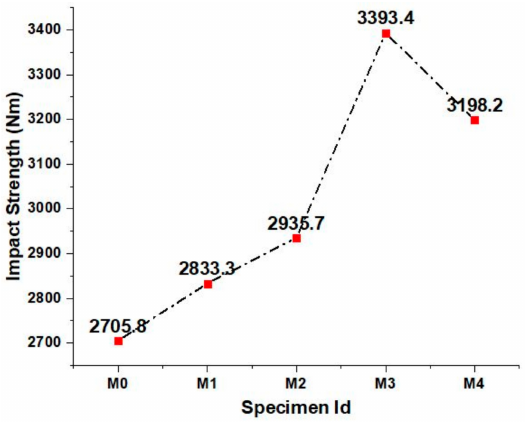
Figure 11. Impact strength of various concrete